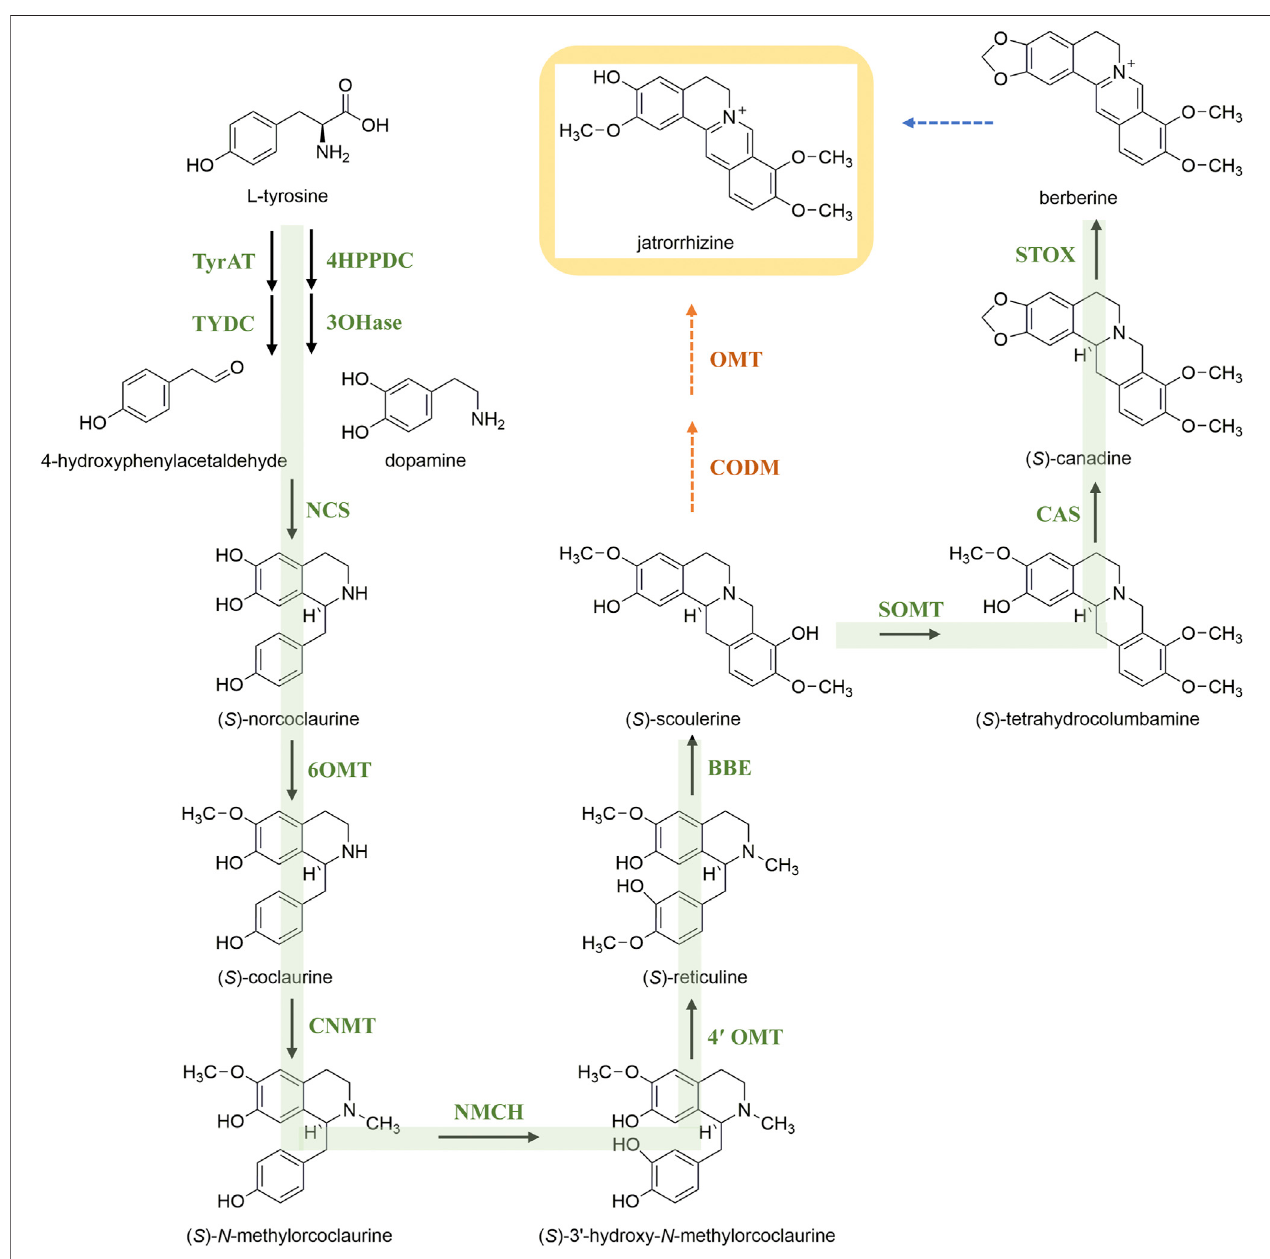
FIGURE 3 | Putative biosynthetic pathway of jatrorrhizine in